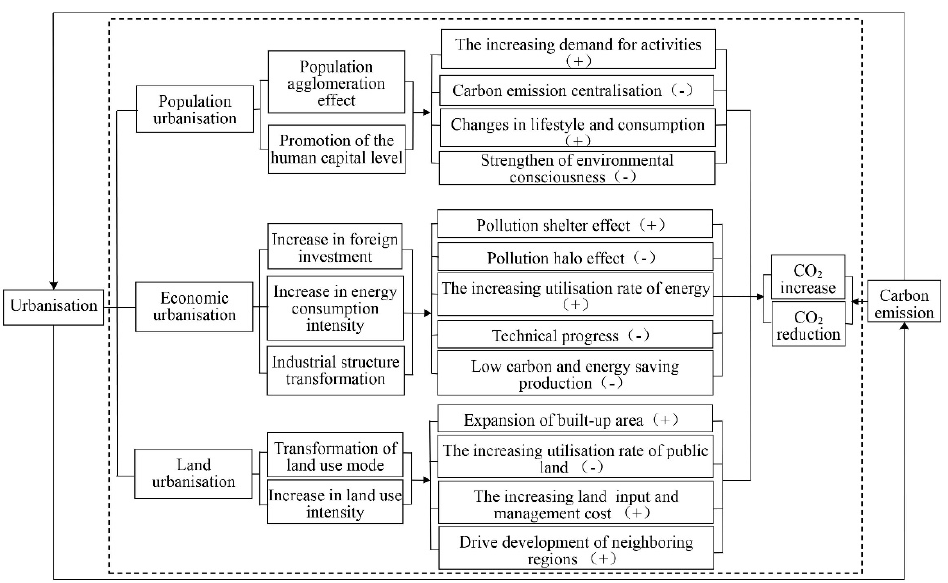
Figure 1. Spatial coupling mechanism of urbanisation and carbon emissions. Note: The symbol ‘+’ represents an increase in carbon emissions and ‘ − ’ represents a decrease in carbon emissions.